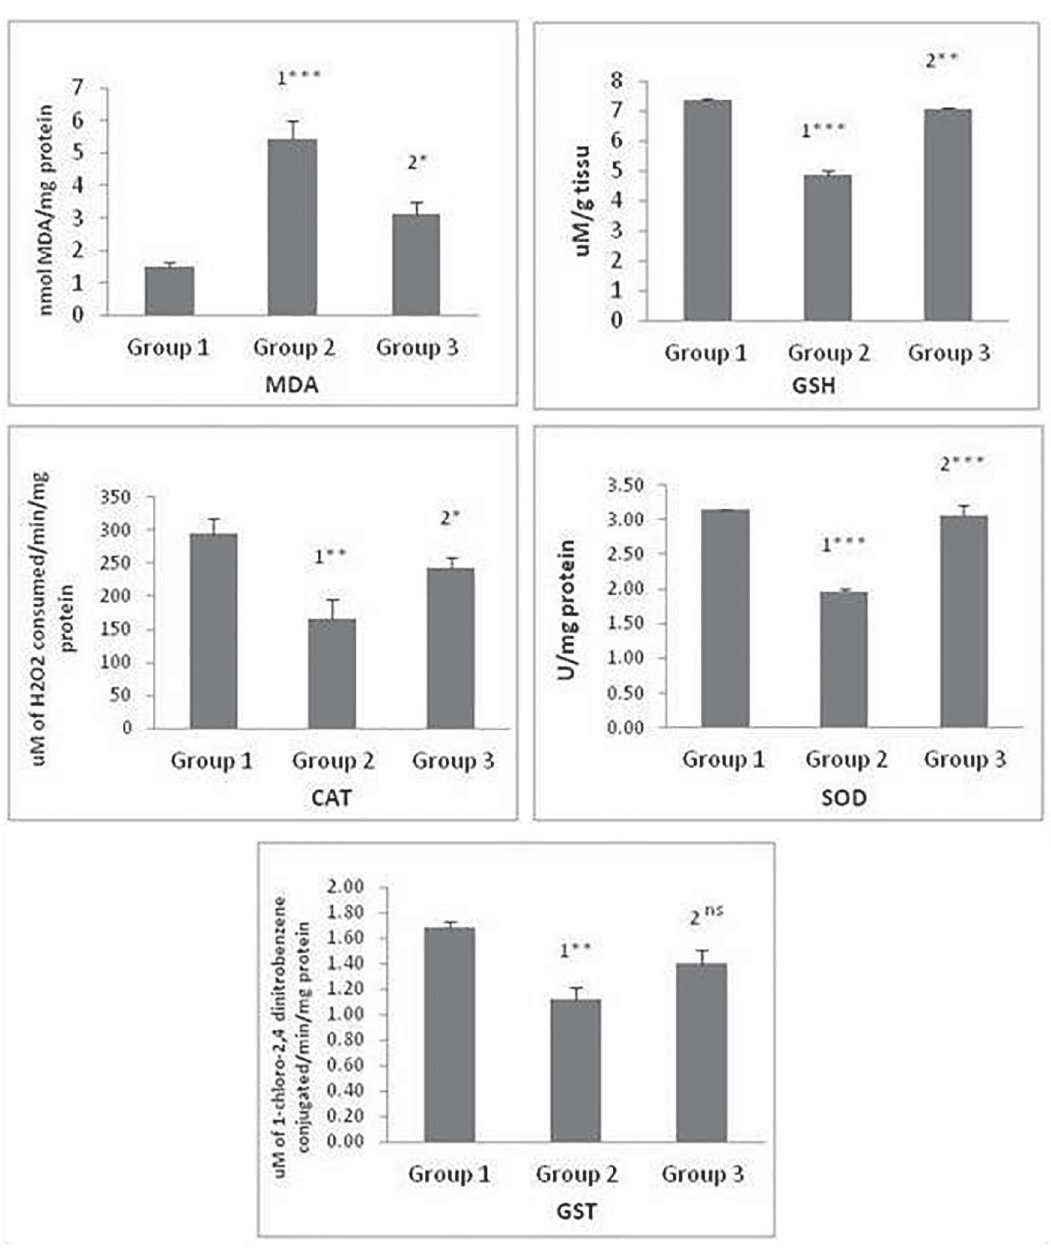
FIGURE 4 – Effect of the Algerian propolis extract on oxidative stress parameters. Each value is expressed as mean ± standard deviation (n = 8/group). p-value < 0.05: significant (*), p < 0.01: very significant (**), p ˂ 0.001: highly significant (***), NS (not significant). 1 group 2 vs. group 1. 2 group 3 vs. group 2. Group 1: control group includes rats that received olive oil;